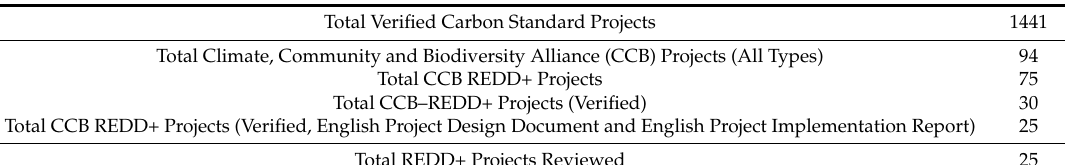
Table 1. Sampling strategy for reviewed Reducing Emissions from Deforestation and Degradation (REDD+)